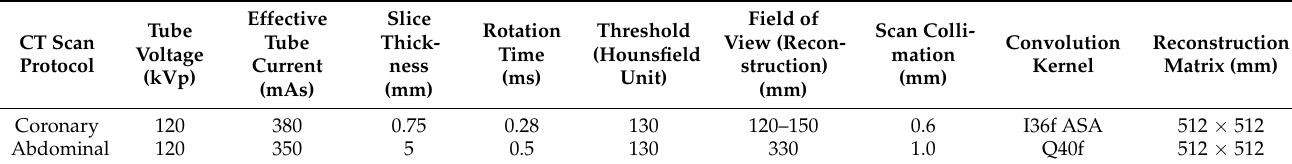
Table 2. Protocols of CT scanner parameters for CCTA and